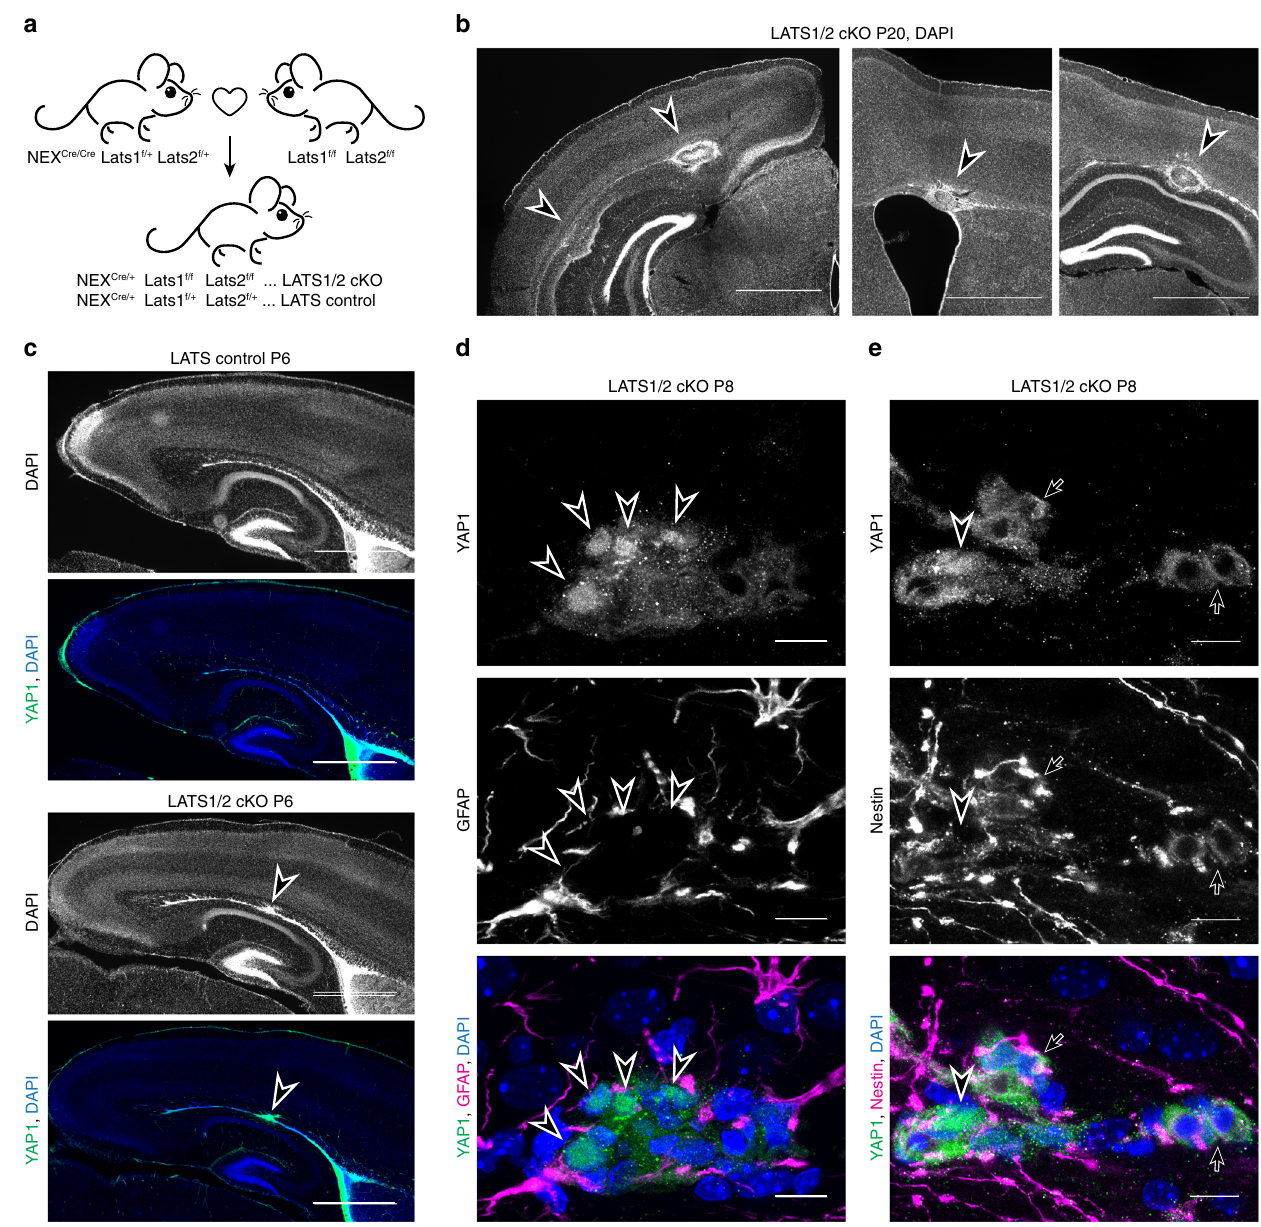
Fig. 3 Conditional knockout of LATS1/2 under control of NEX-Cre leads to clonal YAP1-positive tumours. a Breeding scheme to generate LATS1/2 conditional knockout (LATS1/2 cKO) mice and control littermates. b Tumours associated with the ependymal layer are found in LATS1/2 cKO mice at P20 (arrowheads). Multiple clonal tumours can be found in each brain (middle and right images are from the same brain at different coronal planes). Scale bars = 1 mm. c A coronal section of LATS1/2 cKO brain at P6 shows strong YAP1 immuno fl uorescence staining in a tumour arising from the ependymal layer (arrowhead). Scale bars = mm. d – e Confocal images of immuno fl uorescence stainings in LATS1/2 cKO brains. Scale bars = 10 µ m. d YAP1 staining is increased in the tumour and YAP1 is nuclear in some cells (arrowheads). YAP1 expression does not overlay with GFAP + cells. e YAP1 and Nestin are co-expressed in the tumour cells